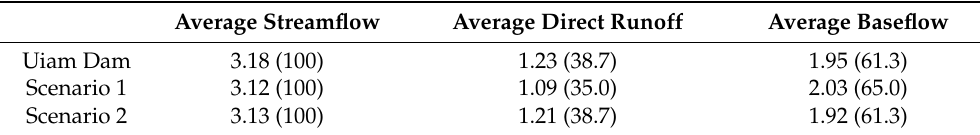
Table 8. A portion of average direct runoff and baseflow from streamflow in Uiam Dam (unit: CMS).